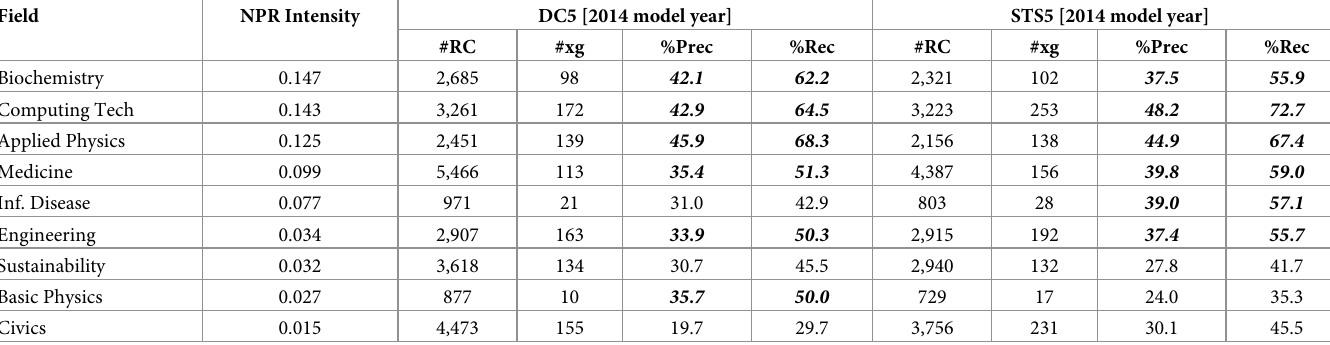
Table 6. Precision (%prec) and recall (%rec) for nine fields of